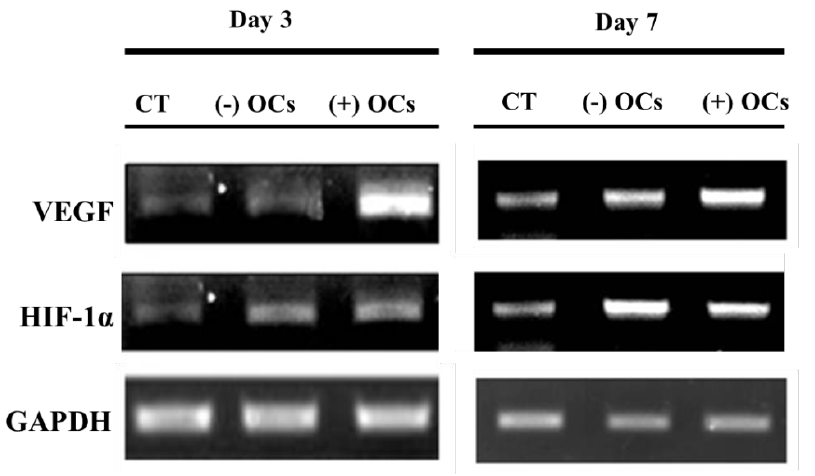
Figure 7. The mRNA expression in HUVECs after cultivation within various scaffolds. CT: control, (−) without, (+) with.